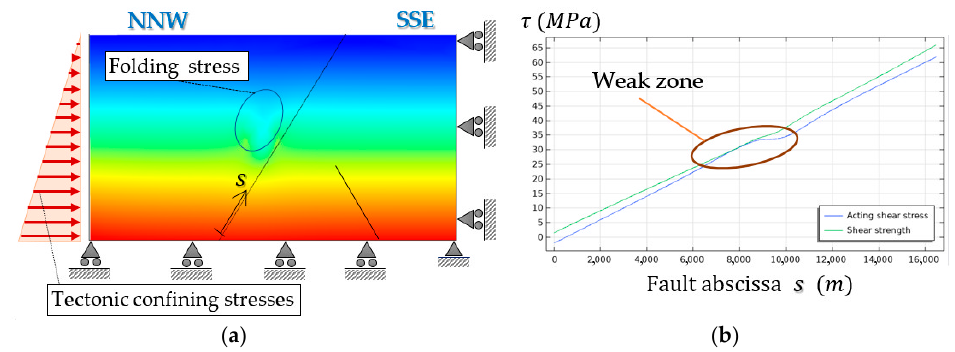
Figure 5. State of initial stresses (von Mises) ( left ) and shear stress state at the fault plane ( right ) at the beginning of the interseismic period. The acting shear stresses (blue) at the highlighted segment are close to the shear strength (green), thus this region is likely to nucleate the earthquake. ( a ) Initial static stress state. It includes an alteration due to the tectonic history. ( b ) Shear stress state at the fault plane.